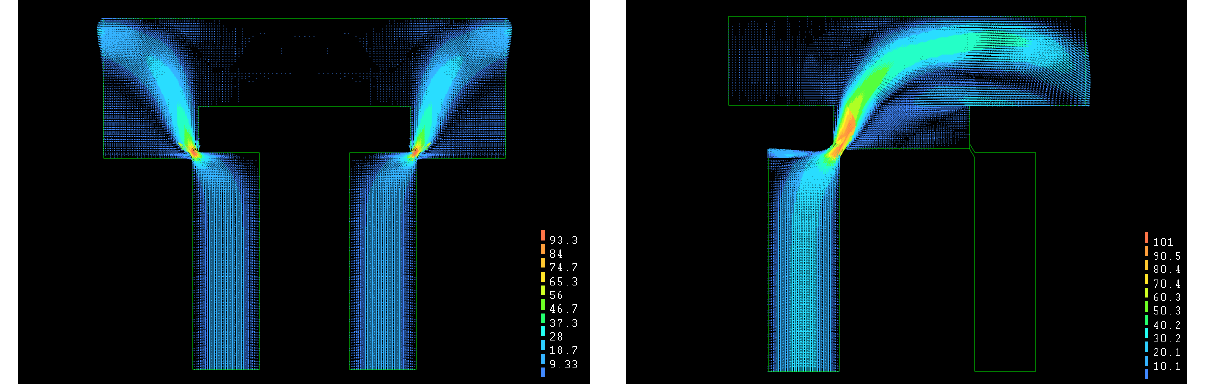
Fig. 16. Velocity profile of the modified design in a working Fig. 13. Velocity profile of the modified design in the neutral mode with embodied outlet nozzles mode without nozzles